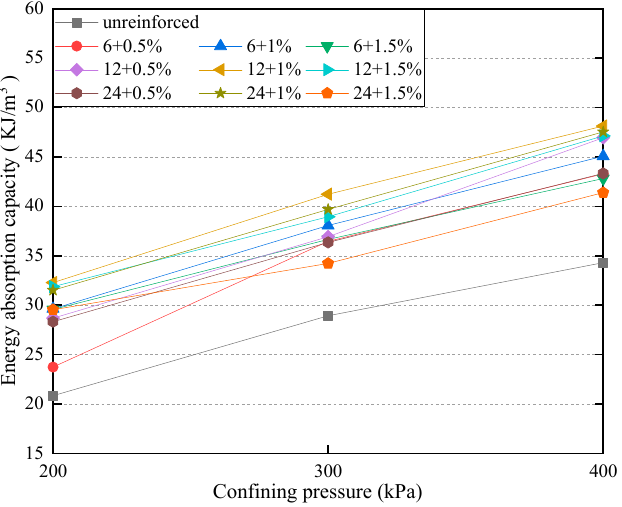
Figure 14. Variation of energy absorption capacity for the specimens boasting various FC and FL.